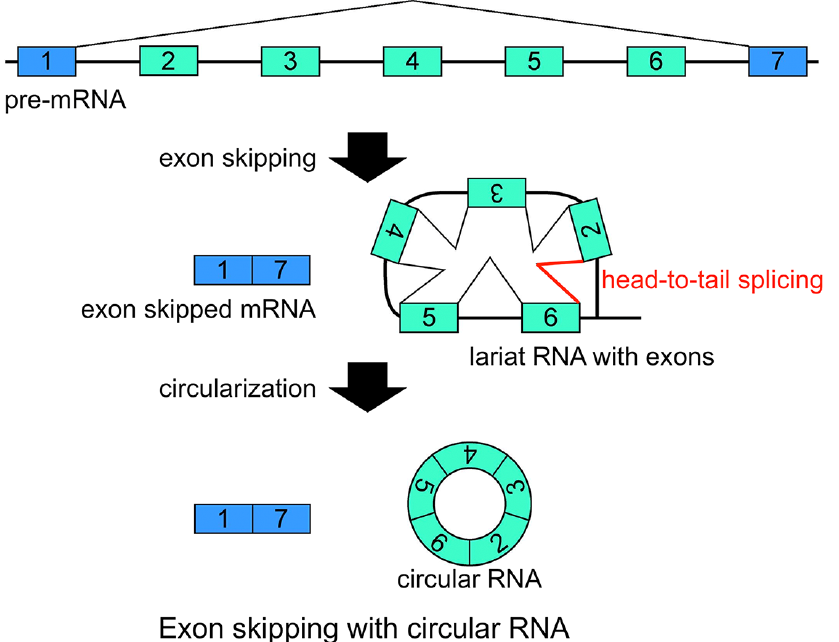
Figure 2. Schematic representation of a model that generates a circRNA. This is one of the most plausible models of circRNA synthesis. The red color indicates head-to-tail splicing. Although this figure is drawn to show that the conventional splicing events in intron 2 to intron 6 happen after the exon skipping event, it is possible that conventional splicing happens before exon skipping. Moreover, even when the lariat RNA contains one single exon, head-to-tail splicing could occur between a downstream donor site and an upstream acceptor